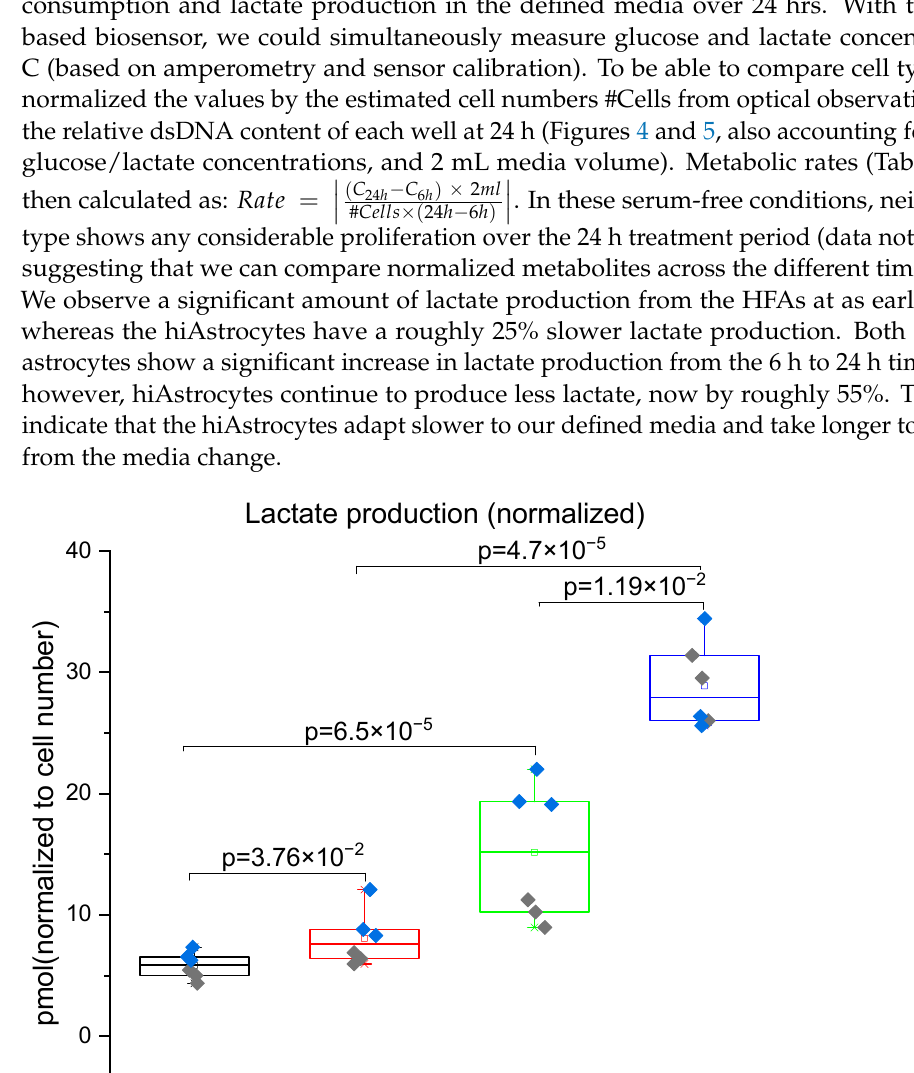
Table 2 . Comparison of the median metabolic rate of the cells in our study and previous studies .